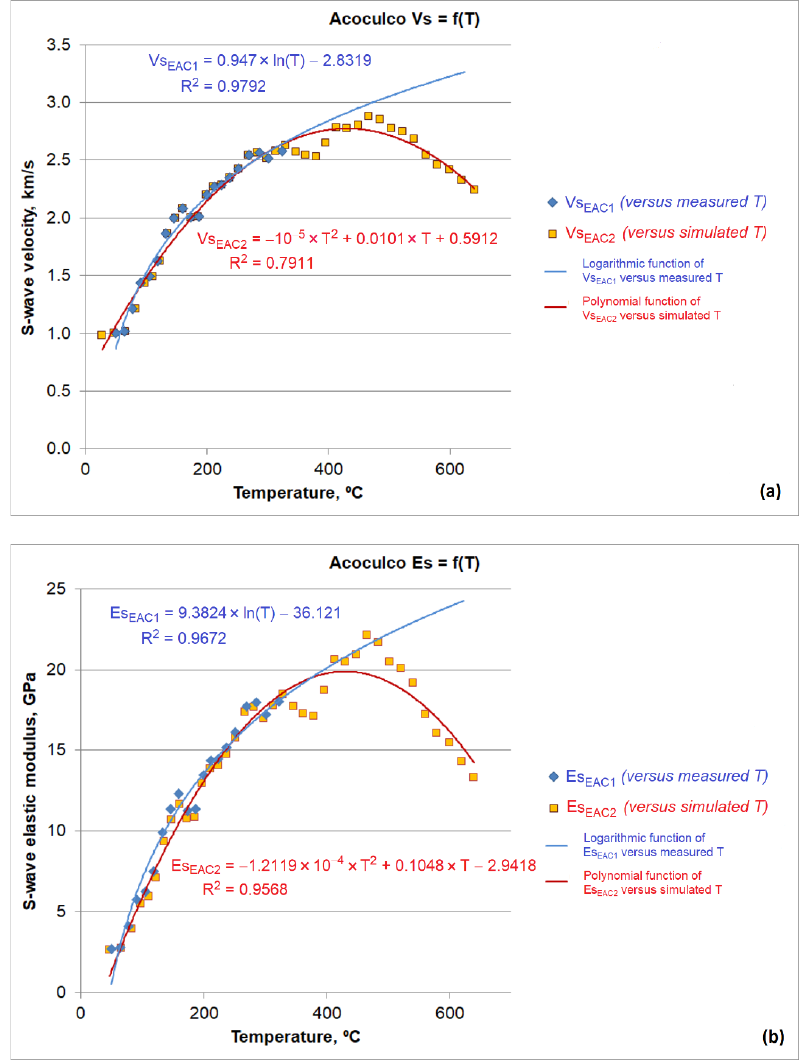
Figure 7. Correlation of 1-D S -wave seismic velocities V S ( a ) and 1-D elastic modulus E S ( b ), as